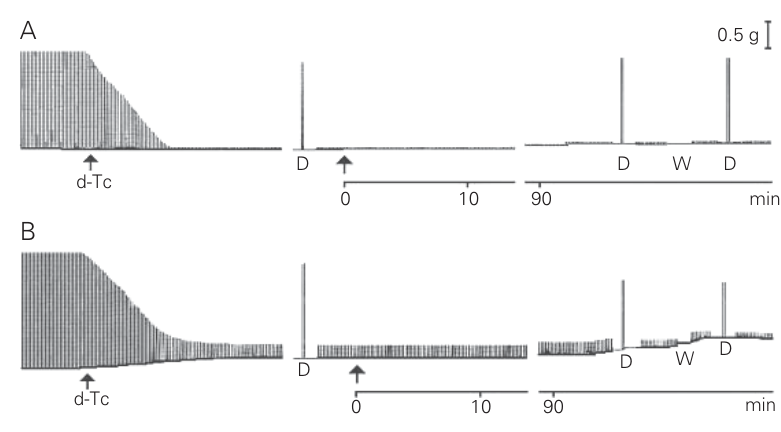
Figure 5. Effect of Bothrops neuwiedii pauloensis venom on the twitches elicited by direct muscle stimulation. A and B , Venom-treated chick biven- ter cervicis preparations at 20 and 50 µg/ml, re- spectively (arrow, time zero). Direct stimulation (D) was applied after treatment with d -tubocura- rine (7.3 µM d-Tc) and after several washes (W) with Krebs solution. These results are representa- tive of 3 and 5 experiments for A and B , respec-